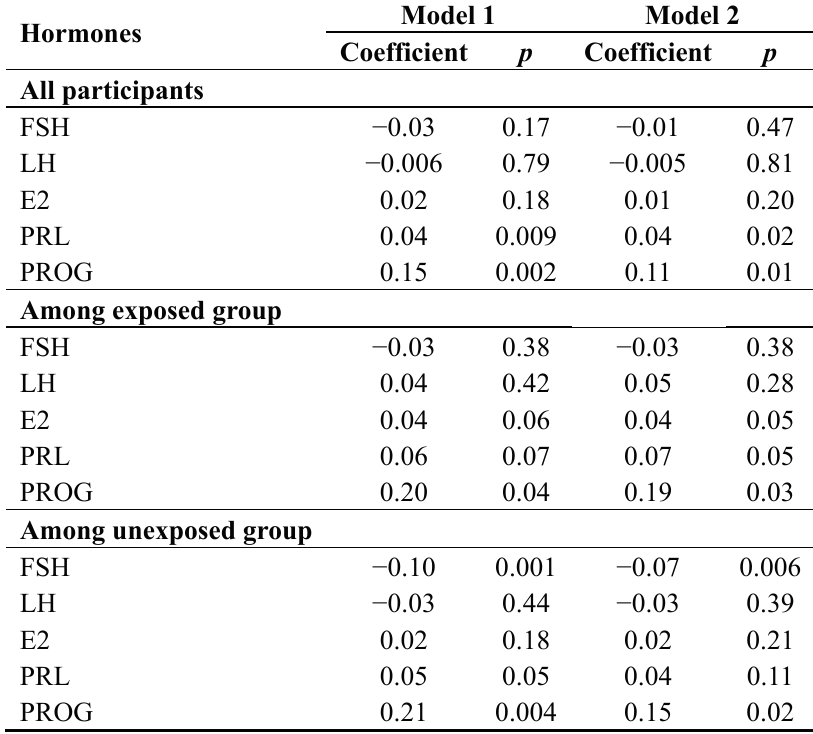
Table 3. Associations between urine BPA and female hormones